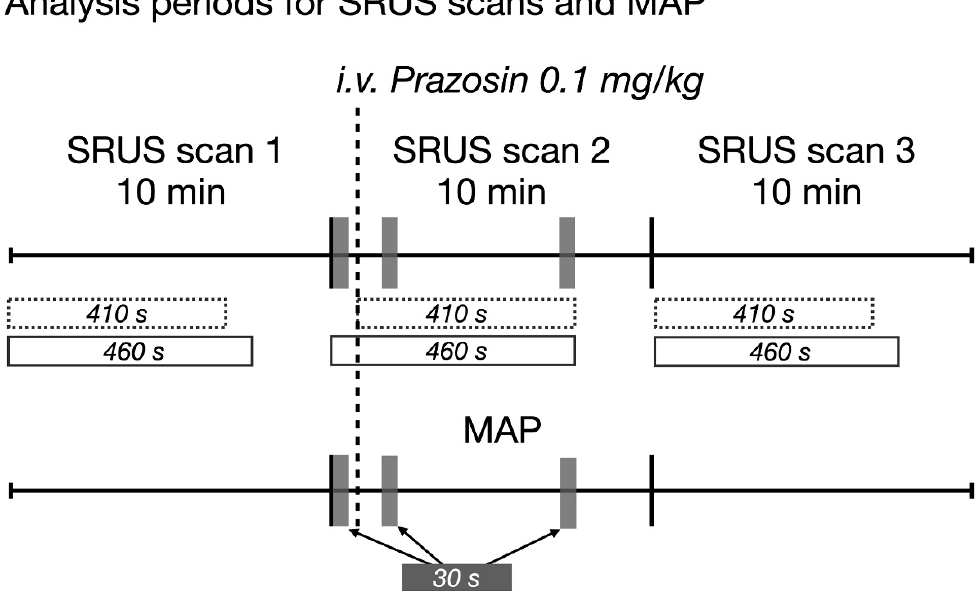
Figure 2. Overview of the analysis periods for the SRUS and MAP data. The 30-s periods compared in SRUS scan 2 and during MAP measurement are marked with grey blocks. The 410 s of SRUS data used to compare the mean microbubble velocity in the three scans are marked by the dotted-line blocks. The 460-s periods shown in the graphs with moving average microbubble velocities are the solid-line blocks. MAP = mean arterial pressure.